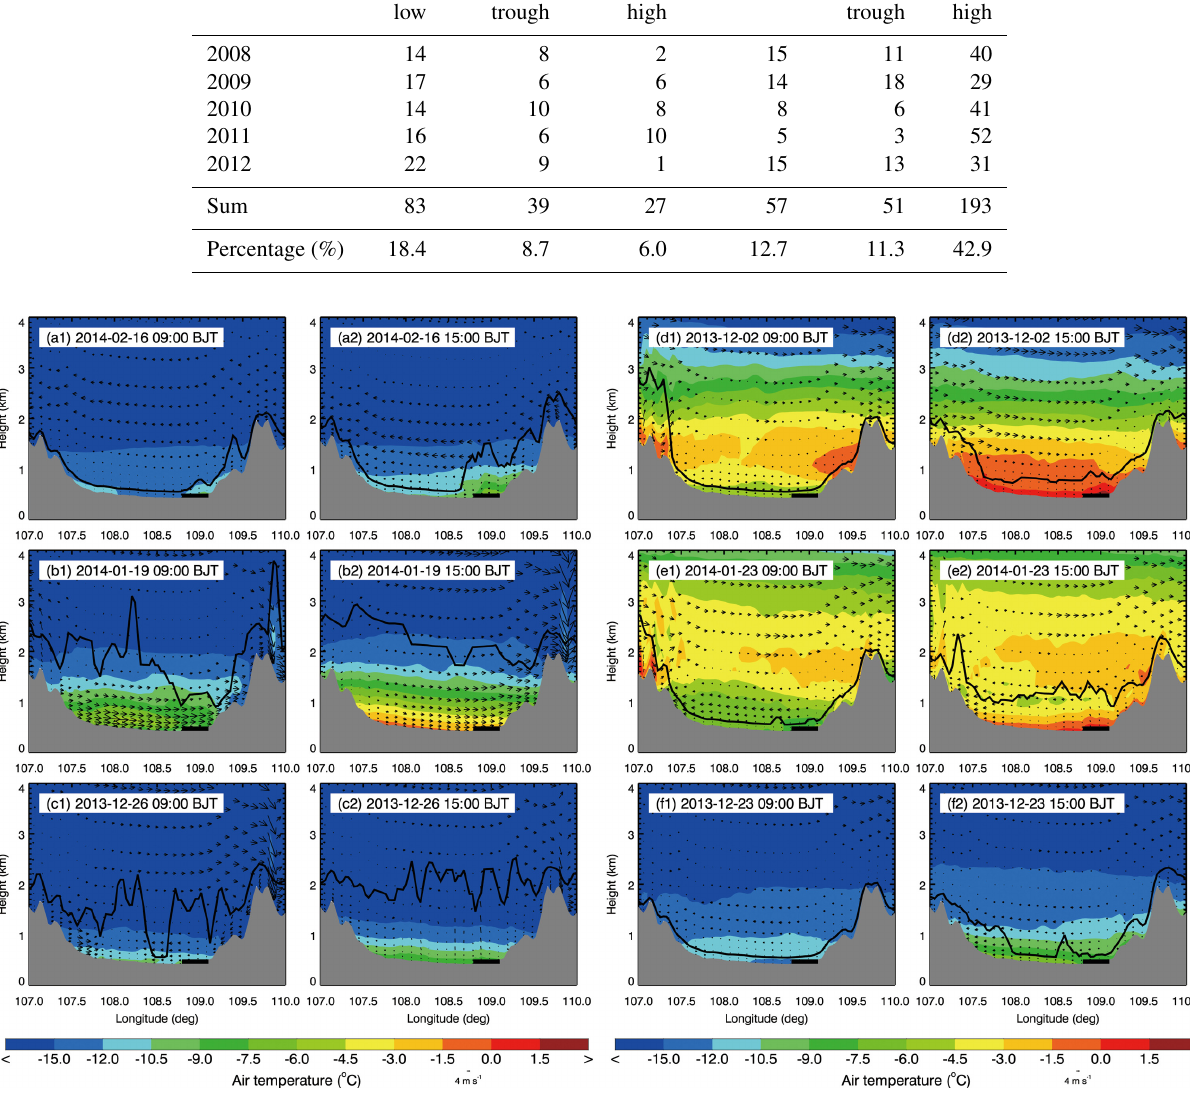
Figure 7. Vertical distributions of temperature, wind vectors, and PBL height along the cross line denoted in Fig. 1b at 09:00 and 15:00BJT on (a) 16 February 2014 (“north-low”), (b) 19 January 2014 (“southwest-trough”), (c) 26 December 2013 (“southeast-high”), (d) 2 De- cember 2013 (“transition”), (e) 23 January 2014 (“southeast-trough”), and (f) 23 December 2013 (“inland-high”). The black filled rectangle represents the urban area of Xi’an,